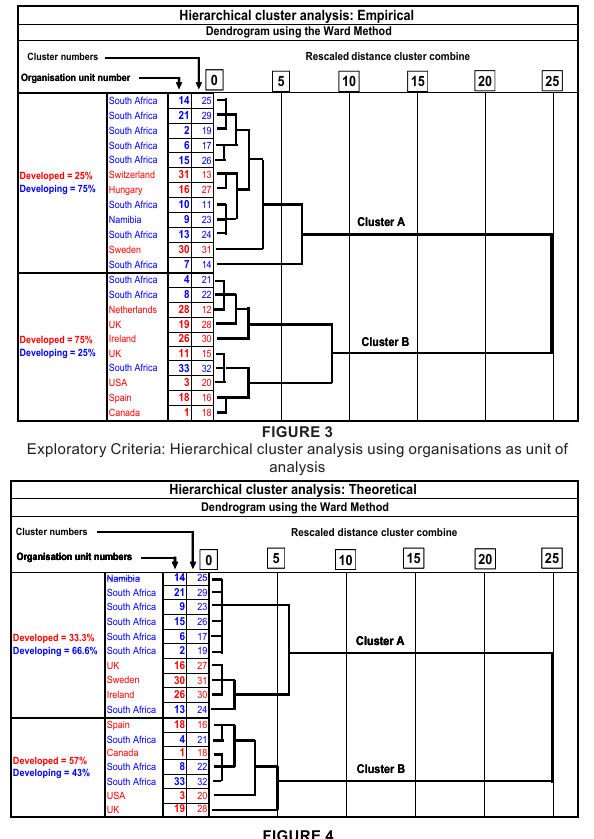
FIGURE 4 Confirmatory Criteria: Hierarchical cluster analysis using organisations as unit of analysis TABLE 6 Exploratory Criteria: Category A (Developing) compared with Category B (Developed)